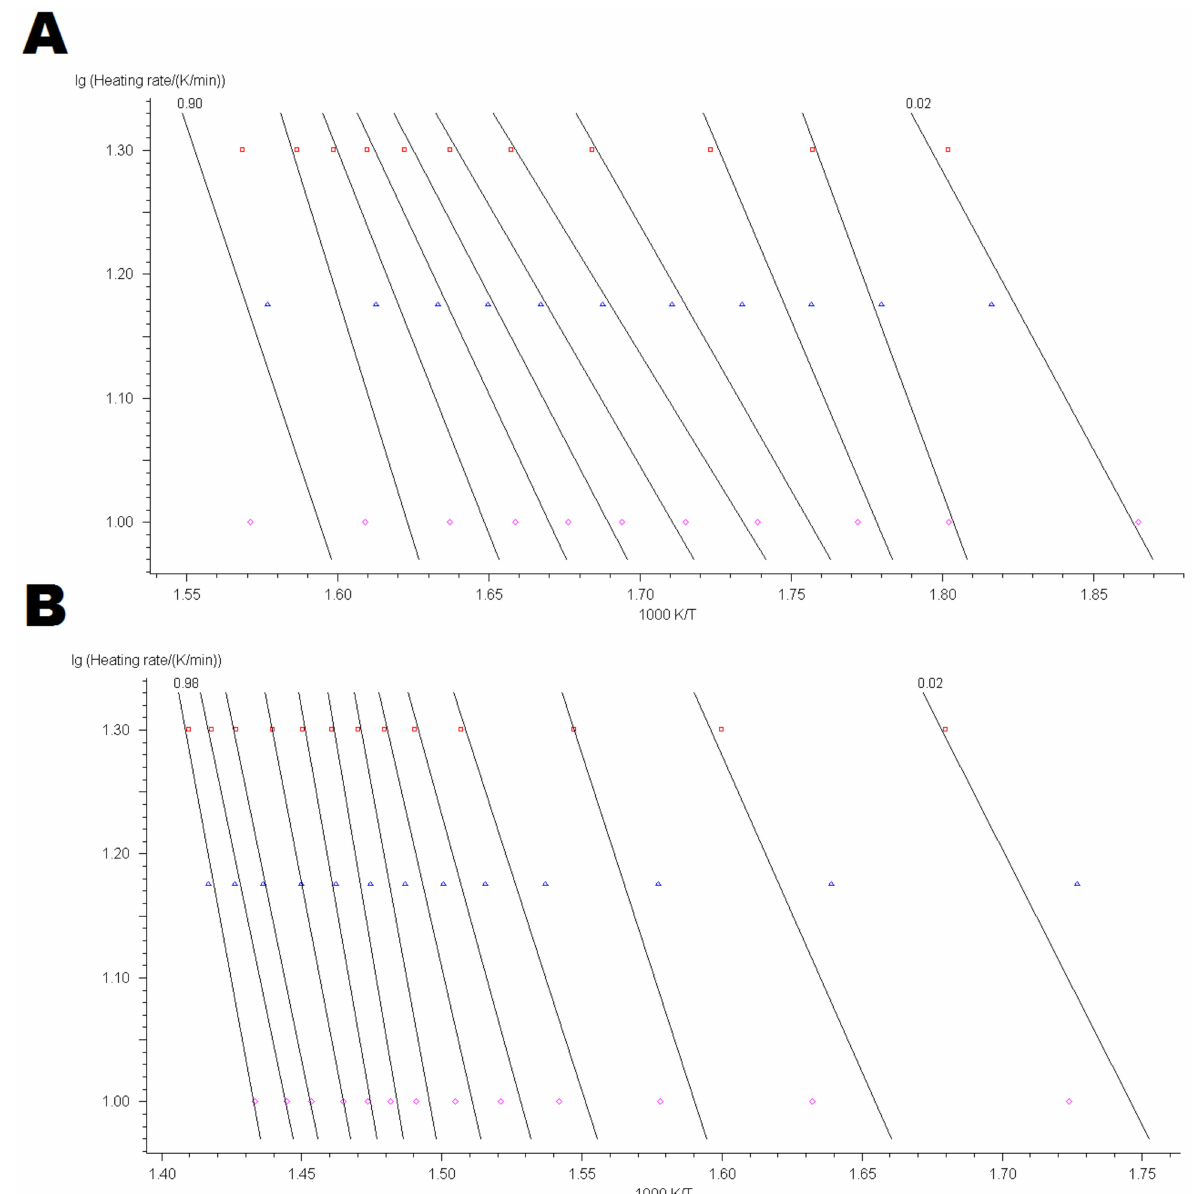
Figure A6. Ozawa-Flynn-Wall POM-O analysis plot lg (heating rate) vs. 1000 K/T: ( A ) sample investigated in an oxygen atmosphere; ( B ) sample investigated in an inert atmosphere. Lines are drawn through isoconversion points for the measurement with 10 ( ♦ ), 15 ( ∆ ), and 20 ( (cid:3) ) ◦ C/min heating